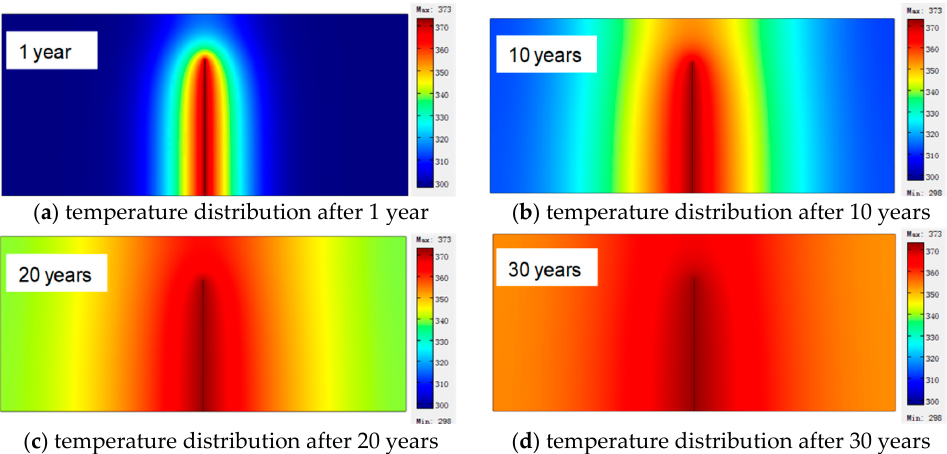
Figure 5. Distribution of coal temperature (K) after different production years.